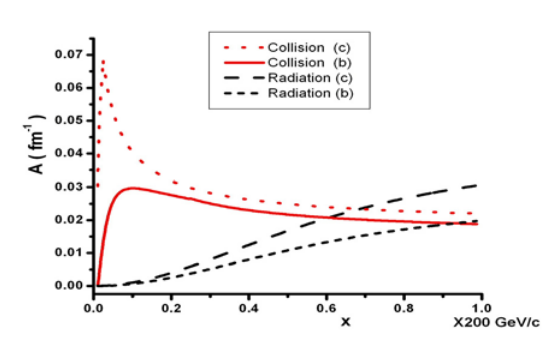
Figure 1: The drag coefficient due to collision and radiation as functions of momentum for Bottom and Charm quarks in QGP.